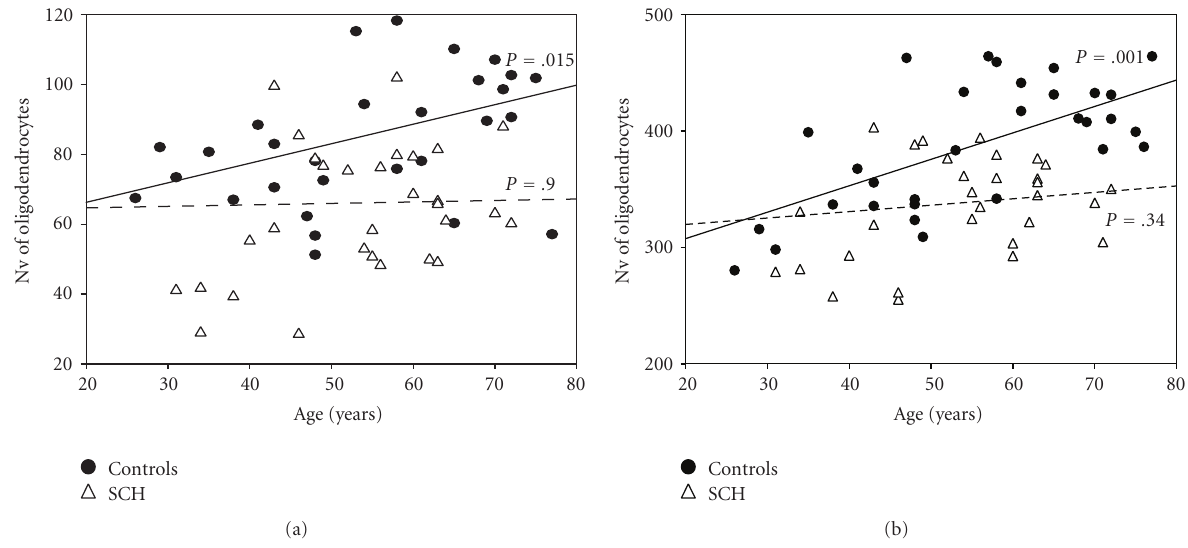
Figure 2: Plots summarizingresults of regression analysisin BA10. There is a significant positive correlation between Nv of oligodendrocytes and age in controls in layer VI ( P = . 015) (a) and adjacent white matter ( P = . 001) (b) but no significant correlations in schizophrenia.